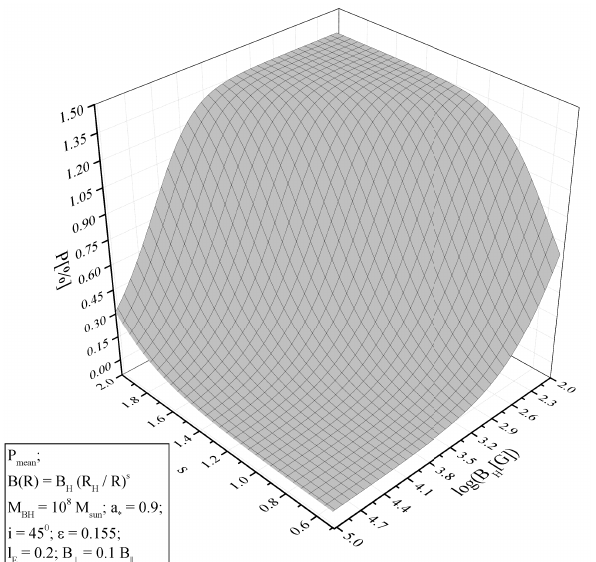
Figure 1. Wavelength-averaged degree of polarization P depending on the value of the magnetic field intensity at the event horizon B H and the exponent of the power-law dependence s of the magnetic field on the radius in the disk.